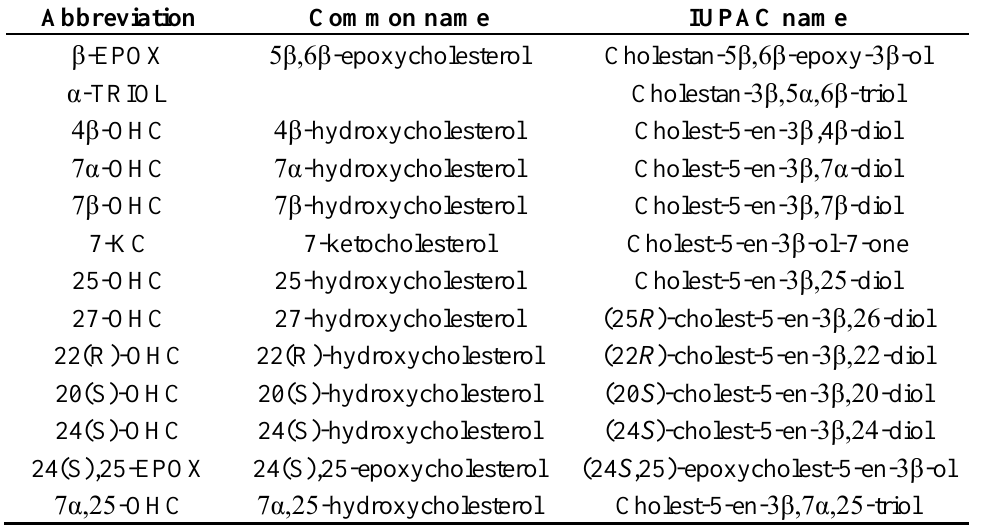
Table 1. Nomenclature of the oxysterols [3] discussed in this